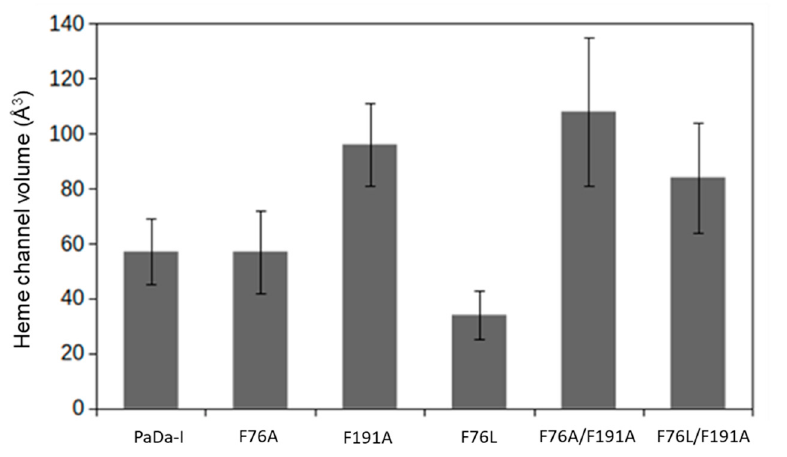
Figure 4. Heme channel volume calculated over the last 100 conformations of the molecular dynamics (MD) simulation.